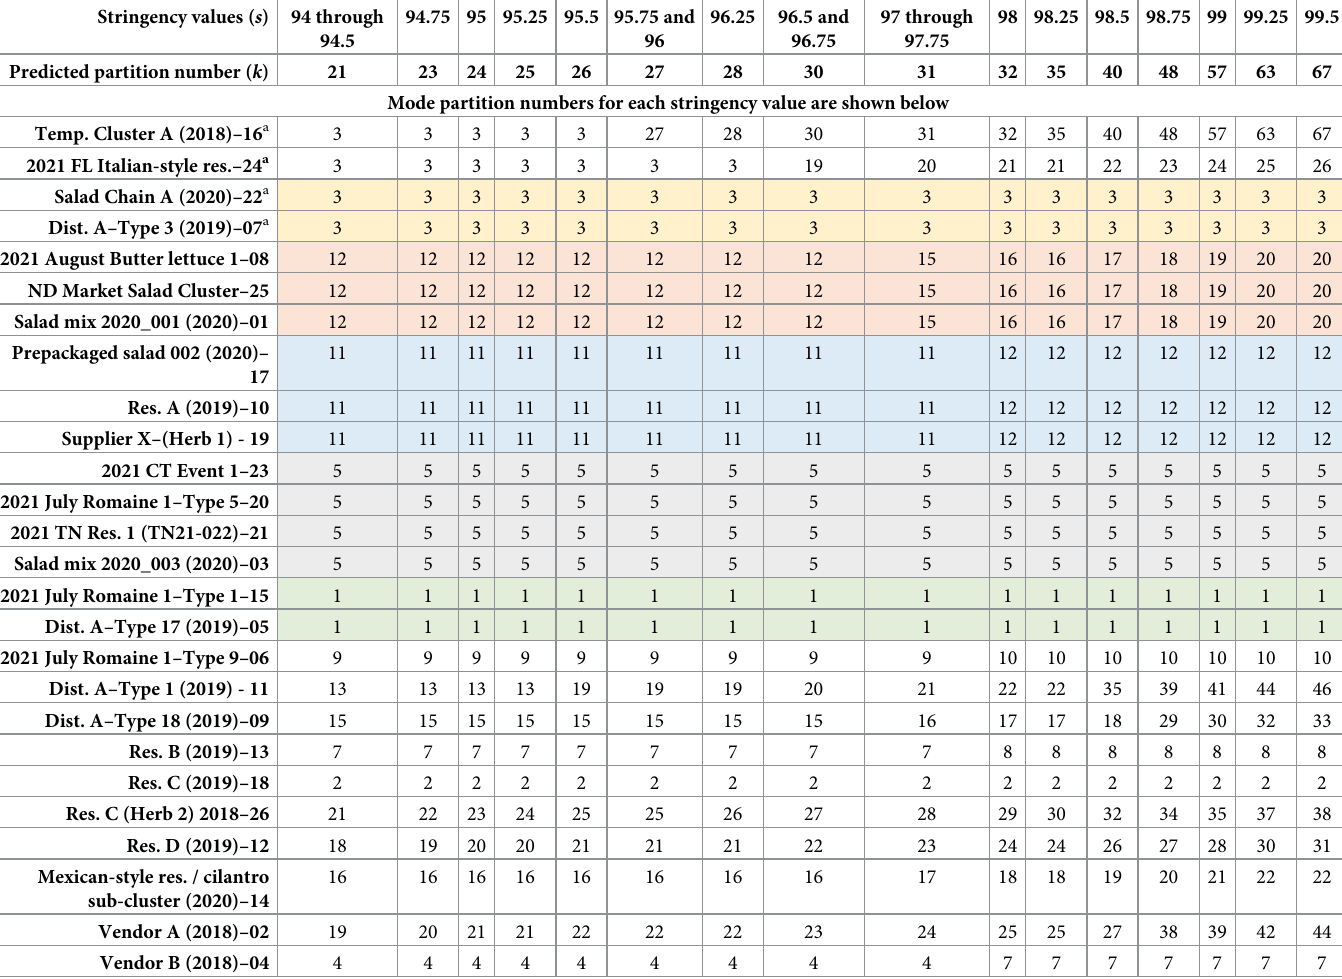
Table 3. Impact of stringency setting on the partition ( k ) membership of genotypes linked to various epidemiologic clusters. Stringency values ( s ) 94 through